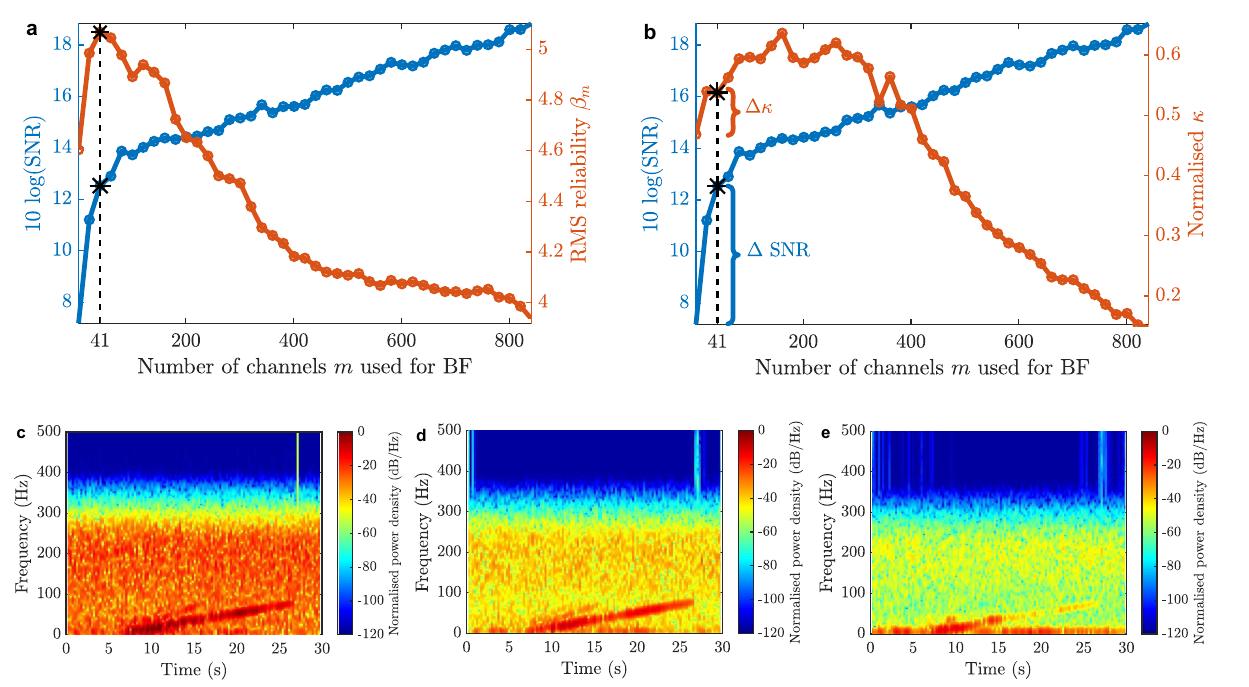
Fig. 5 Blind and non-blind evaluation of the signal enhancement method. a Blind RMS reliability indicator and SNR versus the number of channels used in the beamforming spatial fi ltering process. b Non-blind evaluation of the normalised indicator κ r m and SNR versus the number of channels used in the beamforming spatial fi ltering process. The normalised indicator κ is calculated between the reference acoustic signal r and each beamforming signal BF m , r m normalised by the indicator κ rr based on the autocorrelation of the reference acoustic waveform. Spectrogram of beamforming signals generated for c m ¼ 1, d m (cid:3) ¼ 41, and e m ¼ 863